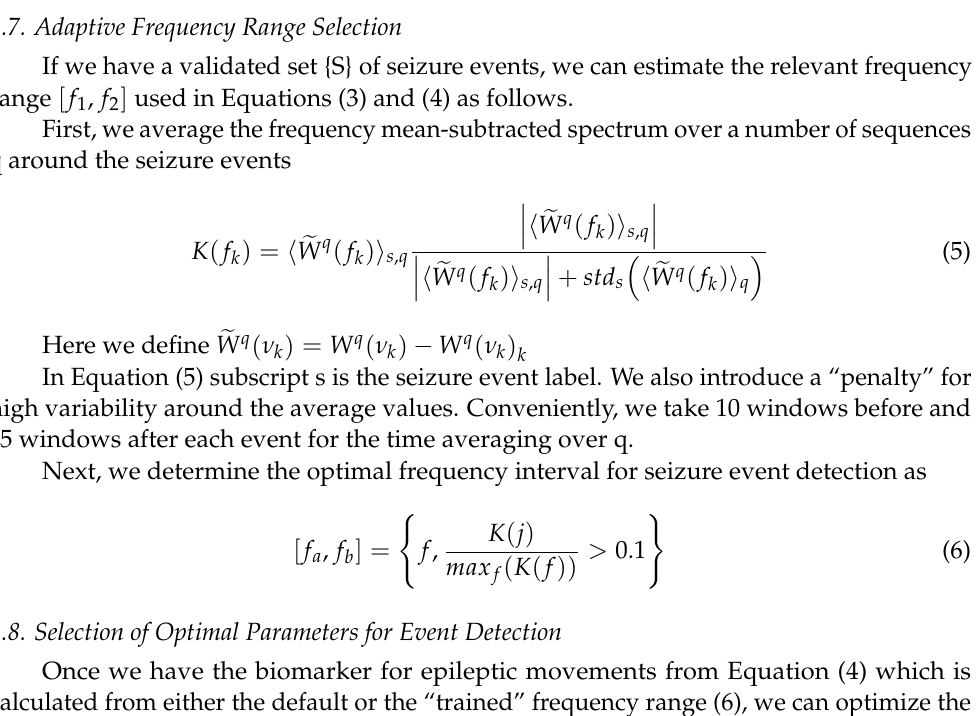
Figure 2. Illustration of the detection algorithm for seizure event. The horizontal axis shows the time or the sequence number. The vertical axis represents the epileptic marker (4). If the marker is occupying more than n points from the tested N, the algorithm generates a seizure event.